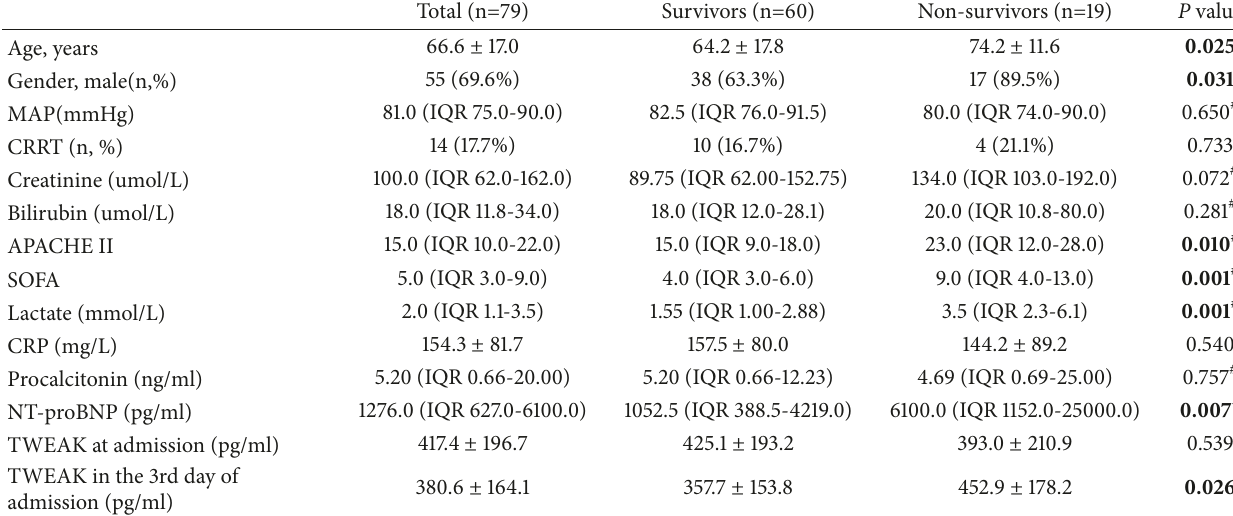
Table 1: Characteristics of included septic